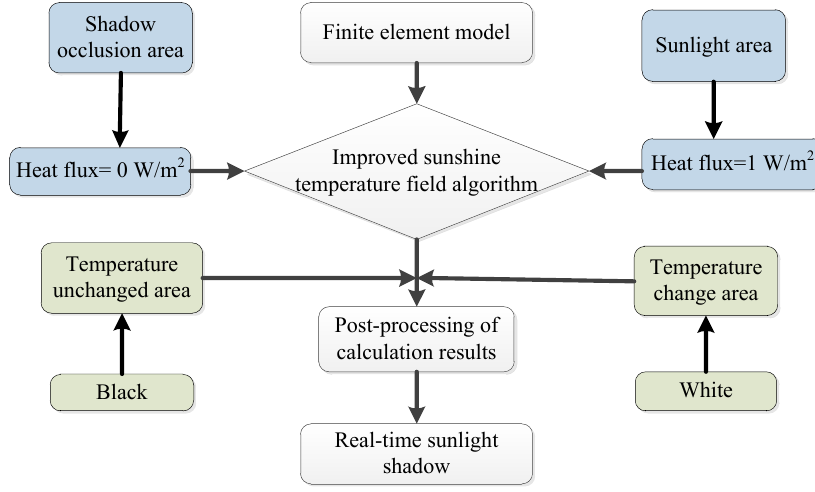
Figure 11. Sunshine shadow display operation